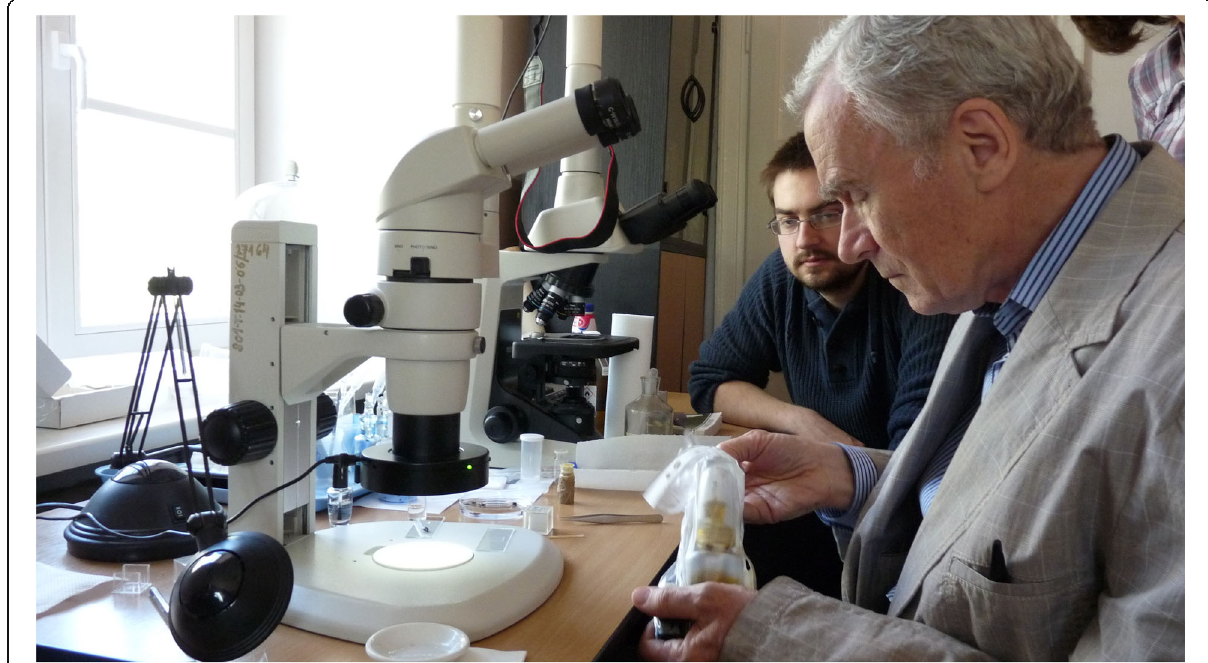
Fig. 26 Tomasz Majewski teaching. Photo: Marta